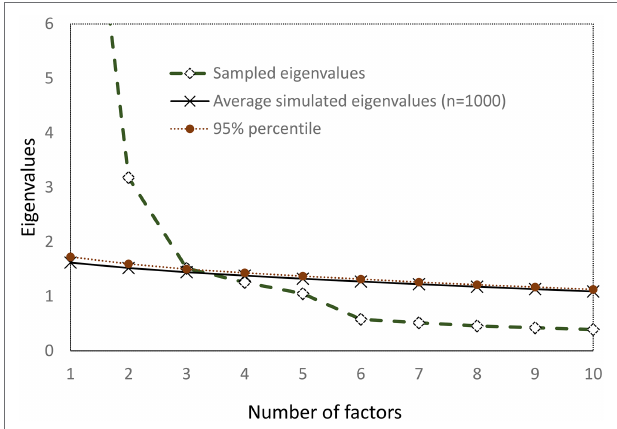
FIGURE 1 | Scree plot of observed and simulated data (Parallel analysis).